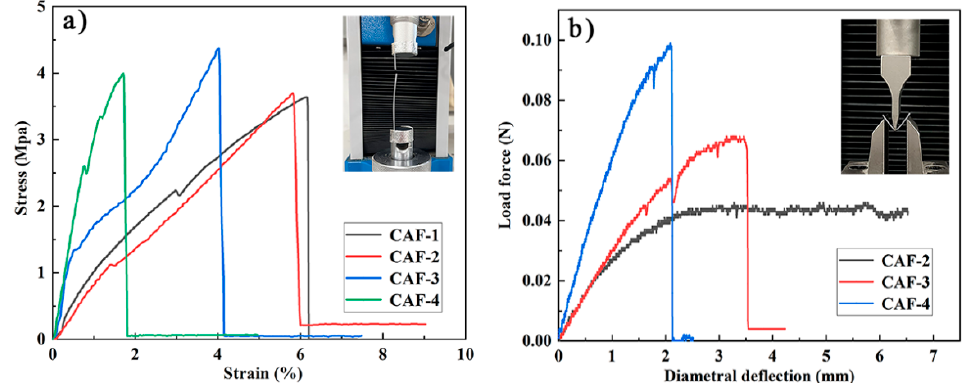
Figure 6. Stress-strain curves of tensile tests ( a ) and three-point bending tests (fixture span is 15 mm) ( b ) of CAFs. Table 2. Compositions, fabrication methods, tensile strength, and densities of the relevant aerogel fibers.